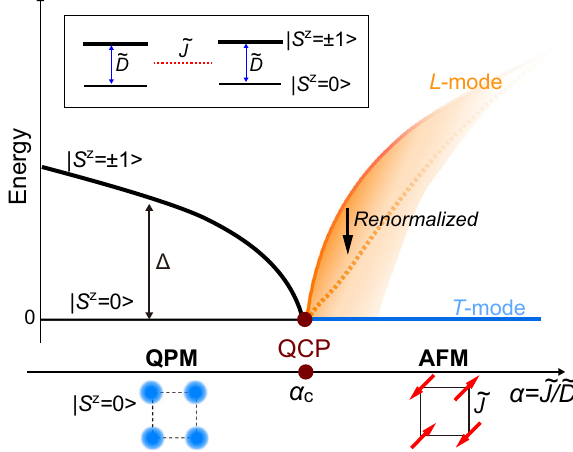
Fig. 1 Schematic diagrams near the quantum critical point. The schematic phase diagram illustrates the O(2) quantum critical point (QCP) between the antiferromagnetic (AFM) state and the quantum paramagnet (QPM) as a function of α ¼ e J = e D ( e J is a Heisenberg exchange and e D is a easy-plane single-ion anisotropy of effective S = 1). The low-energy excitations of the QPM are two degenerate S z = ± 1 modes (black line) with a gap, Δ , which closes at the QCP. The spontaneous U(1) symmetry breaking leads to a gapless magnon or transverse mode ( T -mode), indicated with a blue line, which is accompanied by a gapped longitudinal mode ( L -mode) indicated with the orange line. Near the QCP, the energy and the lifetime of the L -mode are strongly renormalized (dashed orange line) due to the decay into the continuum of two transverse modes (shaded orange